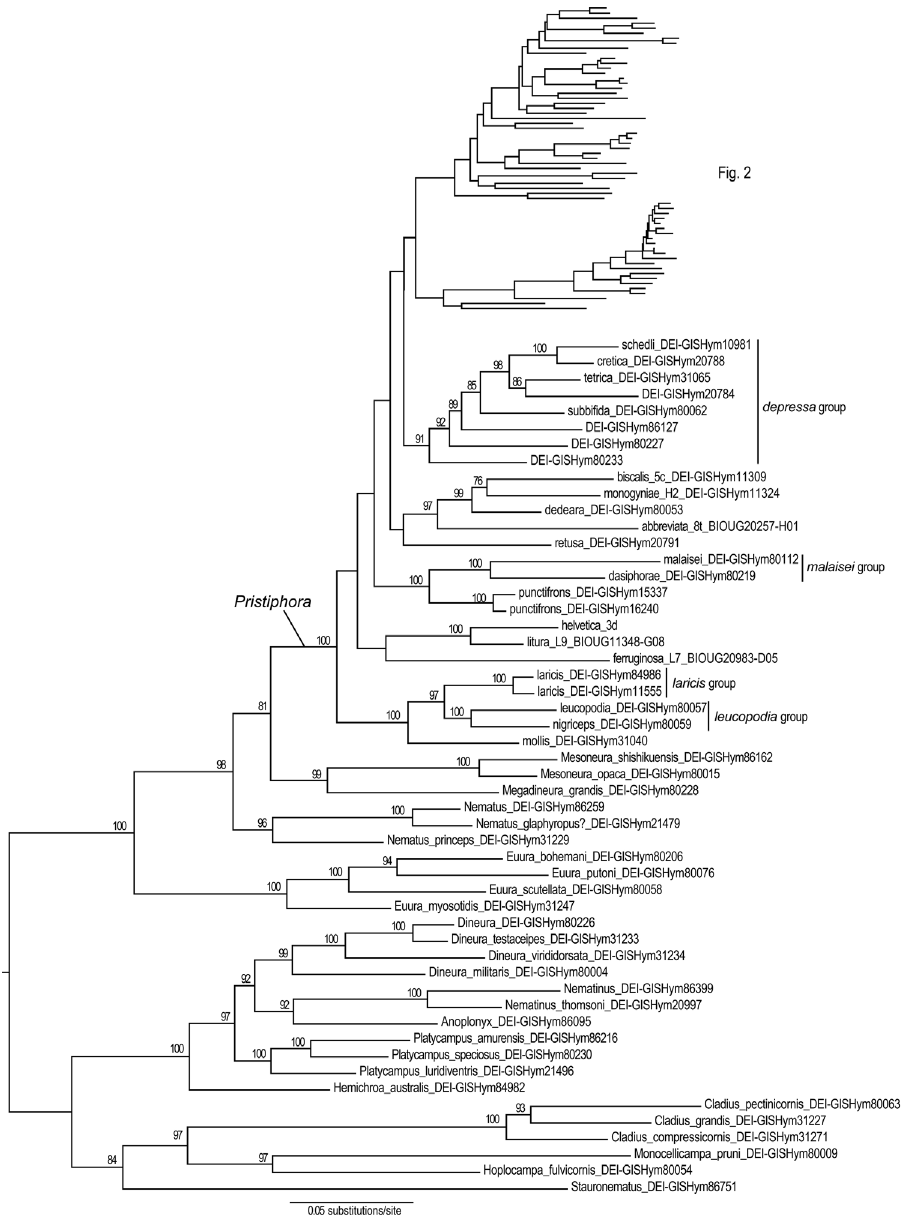
Figure 1. Maximum likelihood tree of Pristiphora and nematine outgroups based on three genes (3408 bp). Specimens having at least two of the three genes were included. Numbers above branches show bootstrap proportions (%). Support values for weakly supported branches (BP<70) are not shown. Part of Pristiphora is shown without support values and tip labels, which are shown in Fig. 2. The scale bar shows the number of estimated substitutions per nucleotide